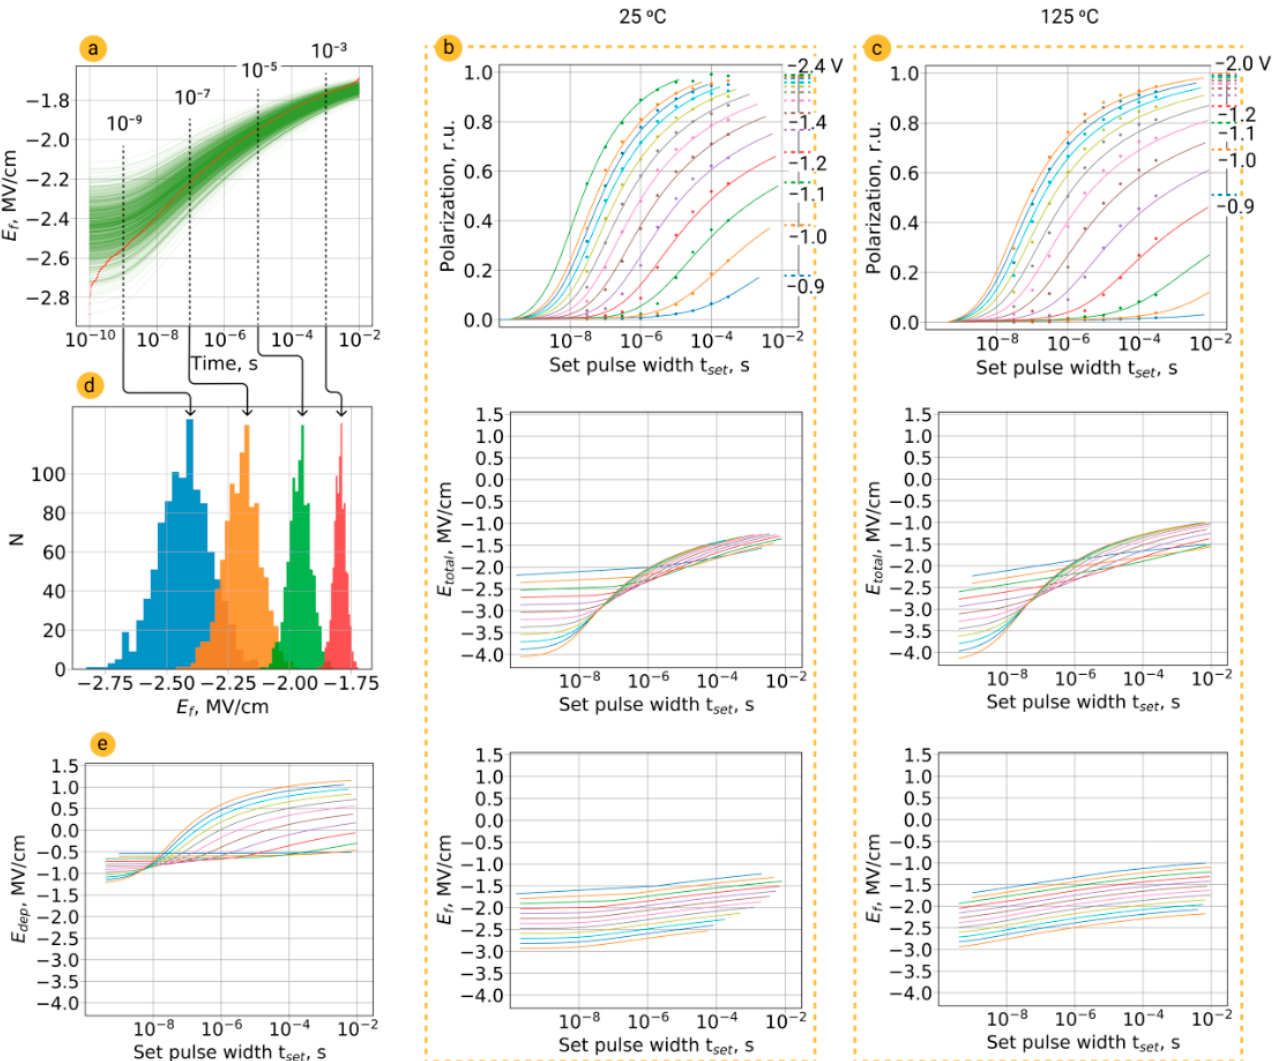
Figure 5. Examination of the general model of switching kinetics. ( a ) E f ( t ) dependence, taking into account the contribution of charge injection for M 0 = 1000 domains with the Lorentzian distribution of the ferroelectric thickness. ( b , c ) Results of fitting of experimental datasets for 25 °C and 125 °C by the general model (solid lines). ( d ) Distribution of fields over M 0 = 1000 domains at different time moments. ( e ) Dependence of depolarization field on time for 125 °C.